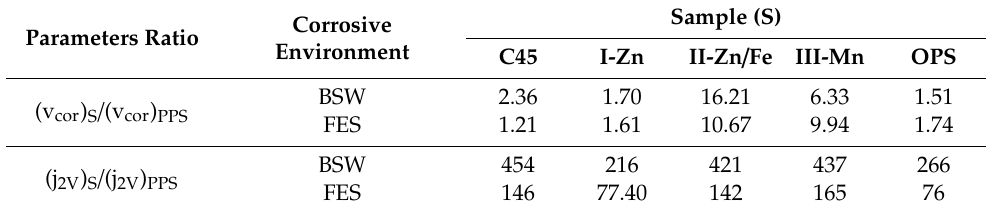
Table 16. Comparison between corrosion rates and current densities between PPS and other samples. Parameters